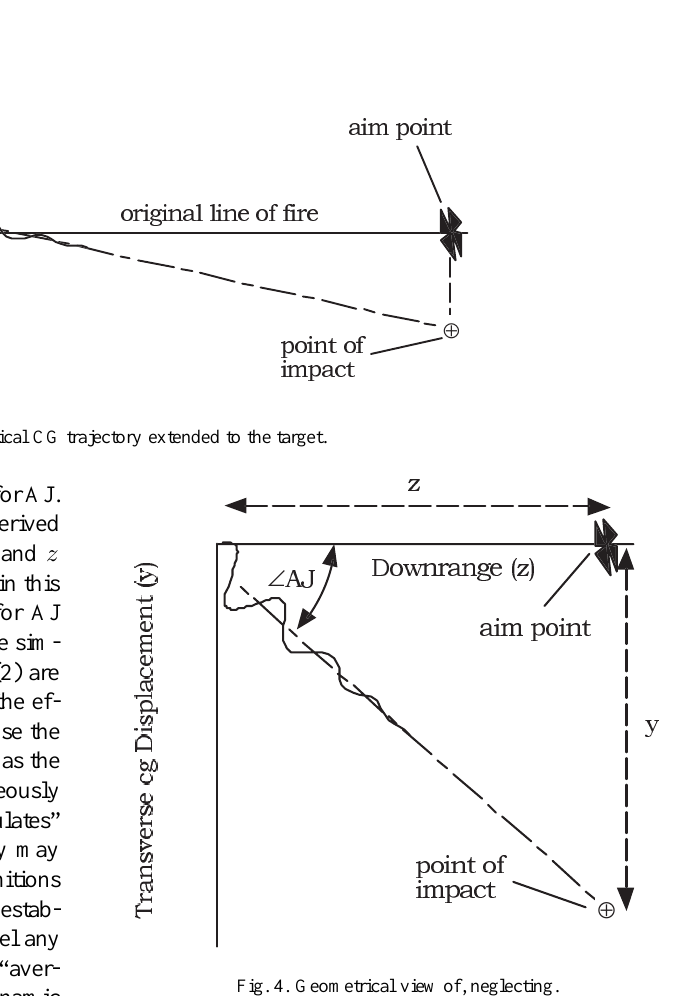
Fig. 4. Geometrical view of, neglecting. Bundy [5], the axis of swerve symmetry runs parallel to the tangent to the swerve curve at any and all of the local swerve maxima (positive or negative maxima with respect to the swerve axis). Hence, ∠ AJ can also be defined as the angular difference between the tangent to the cg trajectory at the origin of FF and the tangent to the swerve curve at the first (or second, or third, etc.) local maximum in the swerving motion. In